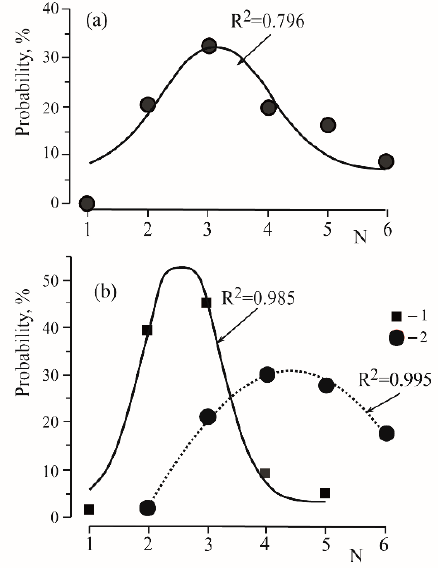
Figure 2. Distribution of Te minerals among mineral systems based on the number of the species-defining elements: ( a ) All minerals, ( b ) O-free (1, solid line), and O-bearing (2, dashed line) minerals. For tellurium minerals, 36 chemical elements were found to be species-defining elements. These elements were divided into three groups: (1) Elements that occur only in O-free minerals, (2) elements that occur in O-free and O-bearing minerals, and (3) elements that occur only in O-bearing tellurium minerals (Table 2). Table 2. The species-defining elements of Te minerals separated into three groups: (1) All minerals, (2) O-free, and (3) O-bearing minerals.